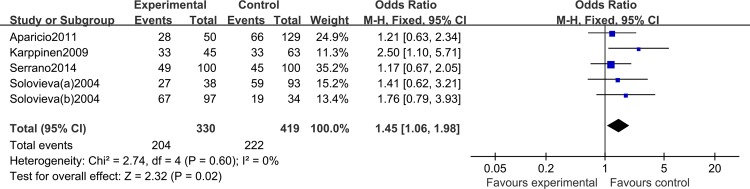
Forest plot of allelic comparison of IL-1α (+889C/T) polymorphism for overall comparison (CT+TT versus CC).